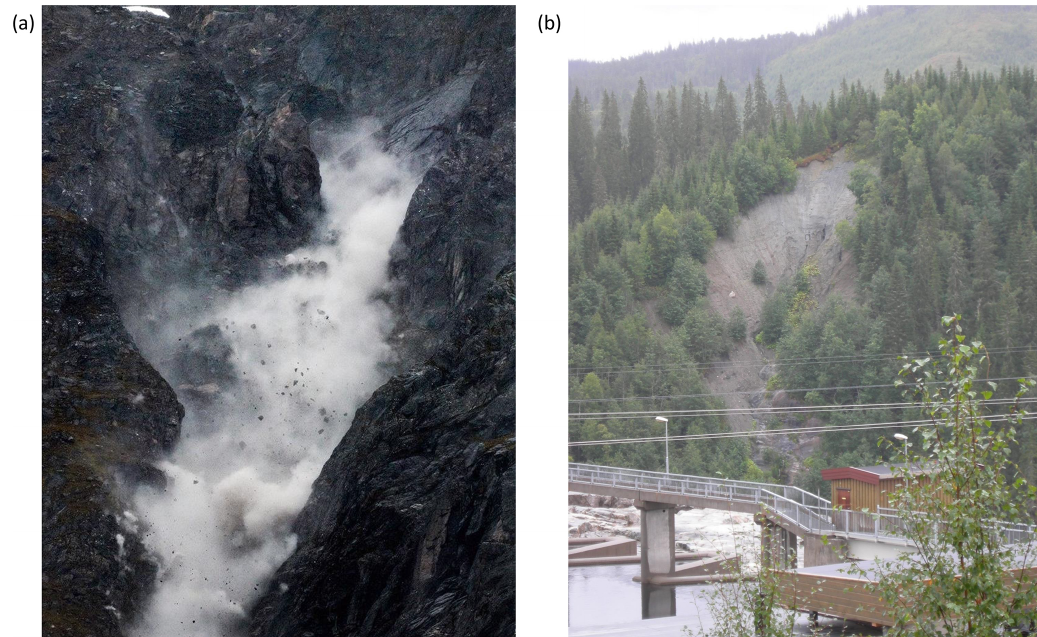
Figure 2. Typical examples of (a) a rockfall (photo: Vegard Lødøen) and (b) a landslide in clayey soil (photo: Rune Halvorsen), which are the landslide typologies most commonly triggered by earthquakes in Norway.